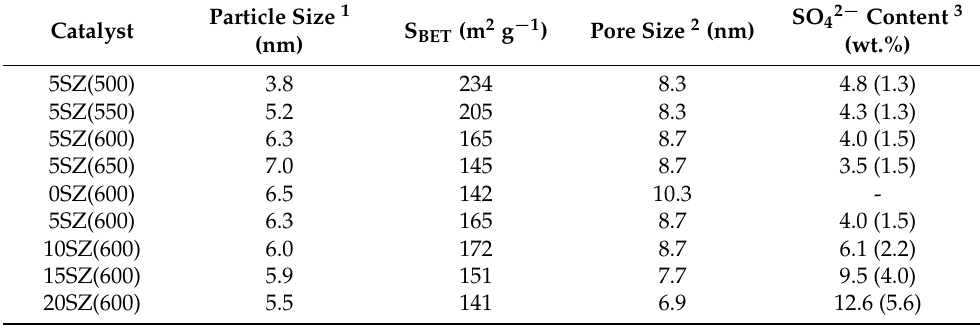
Table 1. Physicochemical properties of x SZ( y )